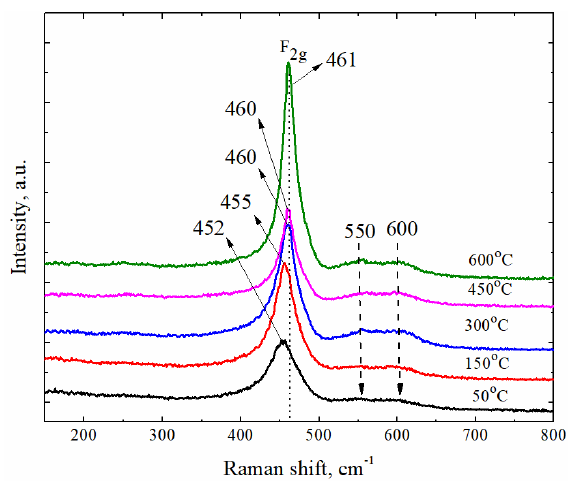
Figure 6. Raman spectra of Sm-doped ceria (SDC20) thin films deposited on SiO 2 substrates at different substrate temperatures from 50 °C to 600 °C and deposition rate 1.6 nm/s.